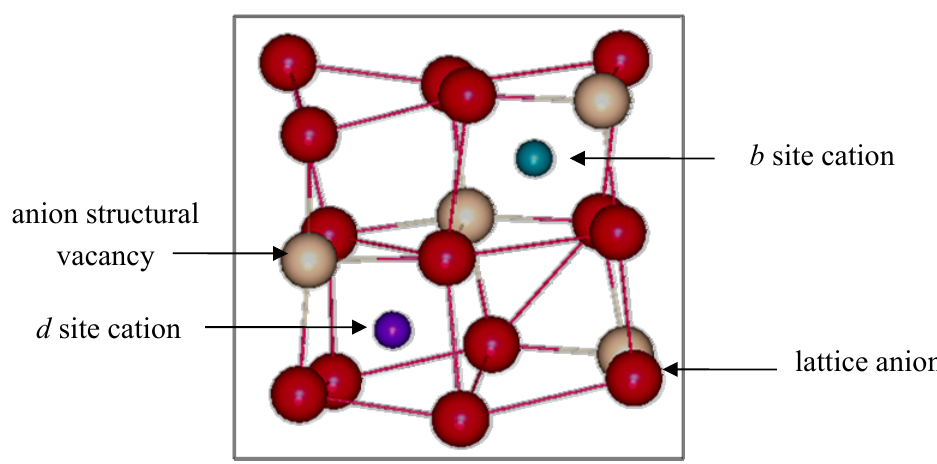
Figure 1. Non-equivalent b and d cations sites found in bixbyite In